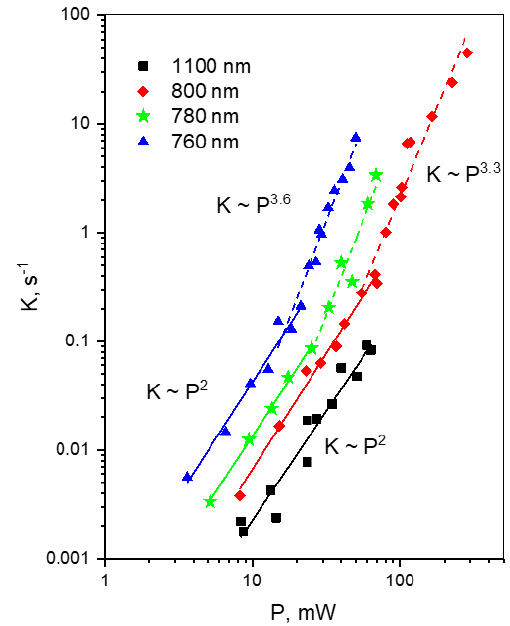
Figure 4. Power dependences of the initial bleaching rate of mCherry at different excitation wave- lengths (see legend in the inset), presented in double logarithmic scale.